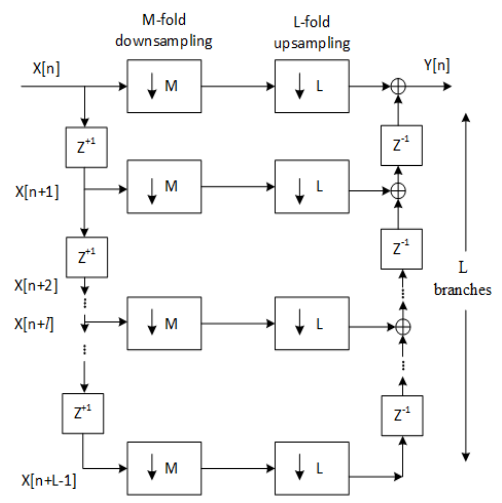
Figure 4. Filter Bank Model where ( L ≤ M )